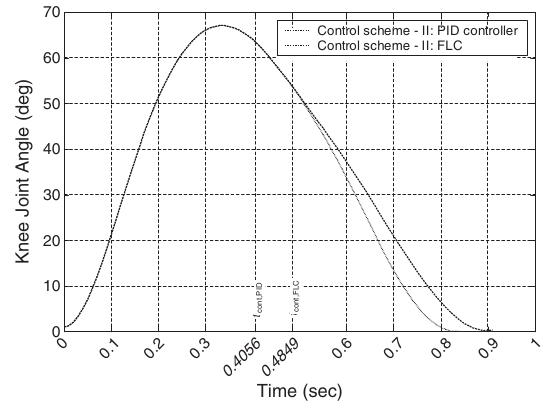
Fig. 15. Non-dominated solution front for MOGA optimization of PID and FL controller under control scheme-II. performance (convergence) by the PID controller than the FLC.